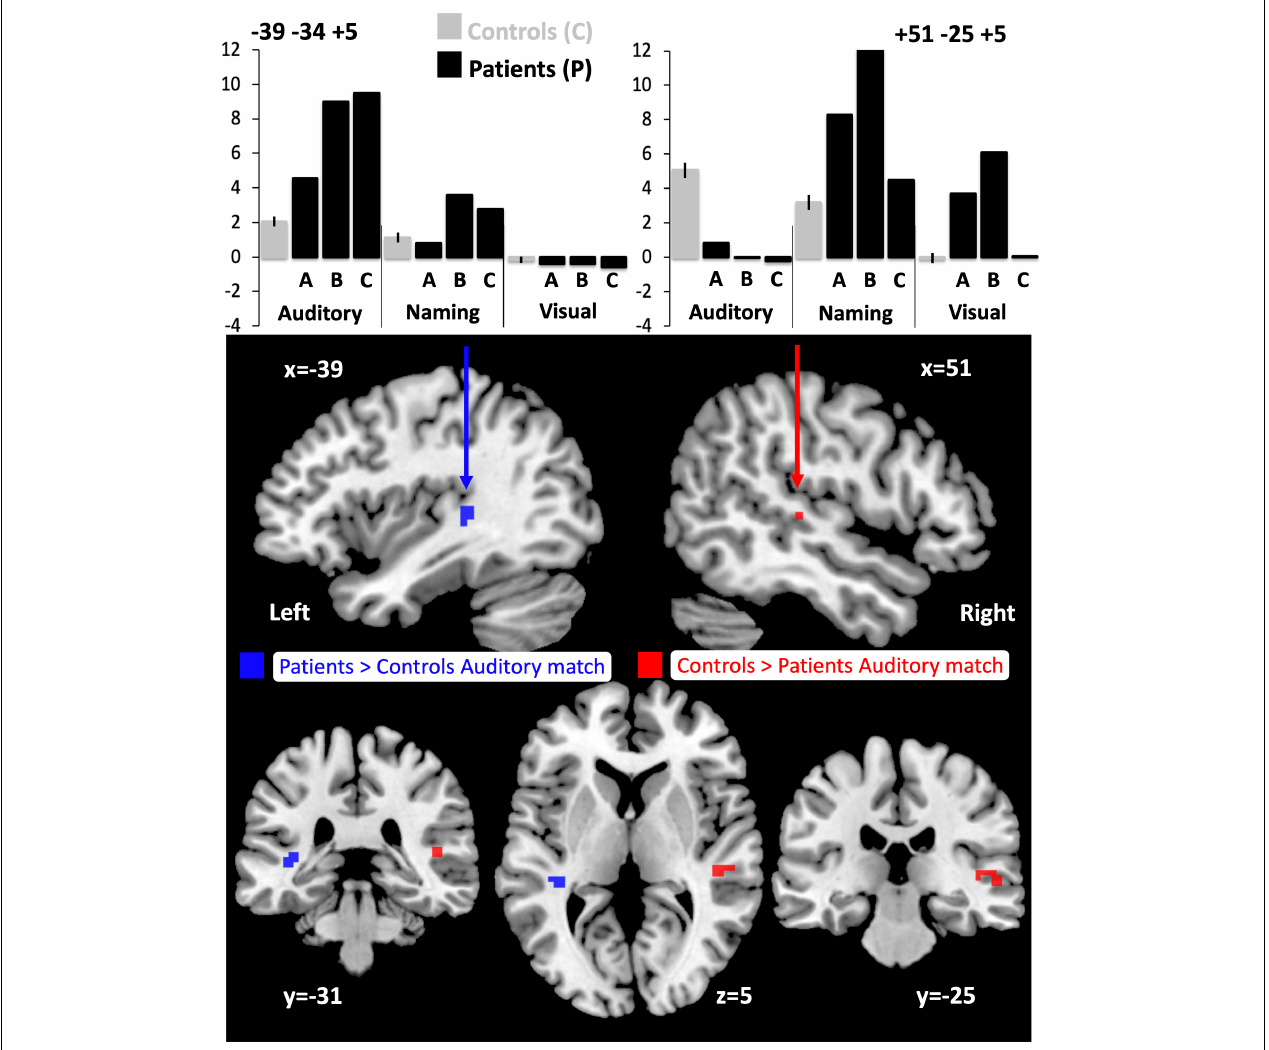
FIGURE 3 | Altered responses during auditory semantic matching, object naming and visual semantic matching in the three RpSTS glioma patients compared with neurotypical control participants. The plots (top) illustrate the fMRI responses in the left [ − 39 − 34 +5] and right [+51 − 25 +5] superior temporal lobes for the three fMRI tasks: auditory semantic matching (auditory), object naming (naming) and visual semantic matching (visual). Y-axis represent the fMRI responses (first eigenvariate extracted from SPM). The images below show the sites of abnormal fMRI activation ( p < 0.05 after family wise error correction across the whole brain) in the patients compared to the neurotypical controls participants (NC), overlaid on a normalised T1-weighted image in neurological convention (right of subject on right of image). Blue indicates the left superior temporal region where patients showed an enhanced response during auditory semantic matching (11 voxels). Red (in the right pSTS) shows where the patients under-activated during auditory semantic matching compared to NC (19